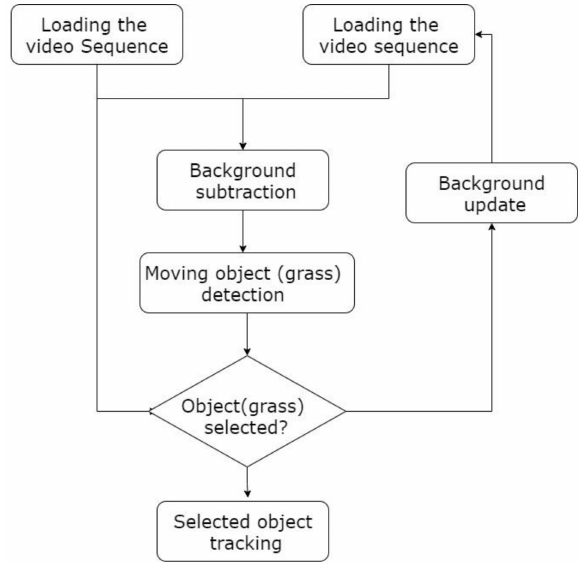
Figure 7. Flowchart of the algorithm used in this